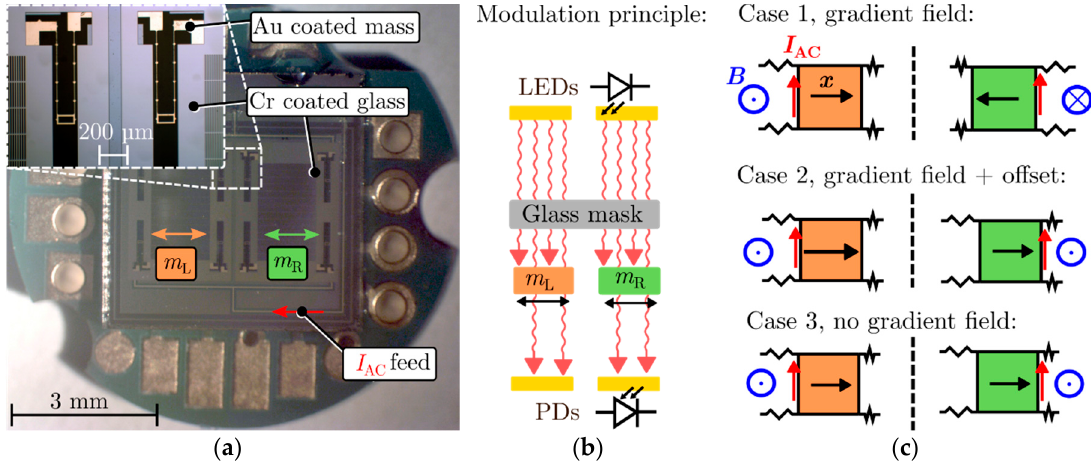
Figure 1. ( a ) Sensor chip bonded onto a PCB board consisting of the two masses indicated as m L and m R . The detailed zoom view shows the stationary Cr coated glass mask on the top and the springs of the two movable masses at the bottom. ( b ) Light is modulated by relative in-plane movement of the glass mask and masses. ( c ) Three potential cases of mass oscillation depending on the field orientation.